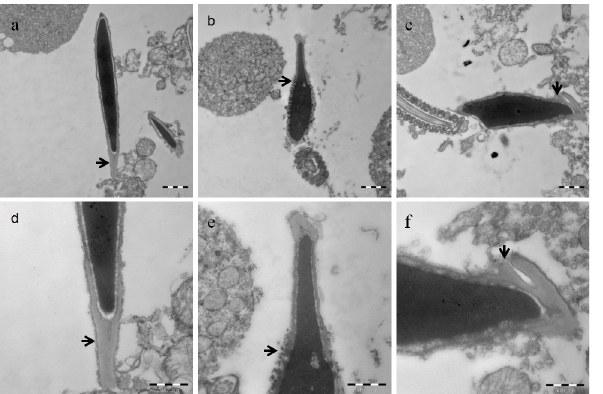
Fig 5. Transmission electron microscopy of sperm from the caudal epididymis. Sperm from the caudal epididymis were analyzed by transmission electron microscopy 3 weeks after miRNA injection. Normal sperm have an elongated condensed head (a, d). The caudal epididymis that corresponding to the testes treated with miR-124 mimic, sperm with acrosome malformations (b, e), or significant acrosome deficiencies (c, f) were observed. Abnormal acrosomes were shown with discrete unfused small acrosomal vesicles around the nucleus; bar = 1 μ m (a-c), bar = 500nm